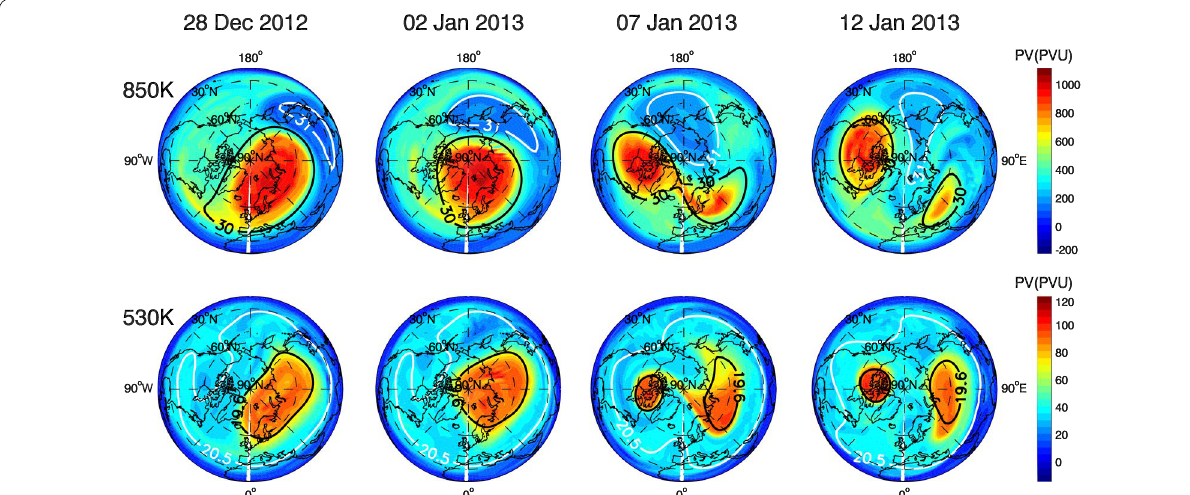
10 − 6 Kkg − 1 m 2 s − 1 ) at 850 K (top) and 530 K (bottom) potential temperature surface Fig. 6 Maps of potential vorticity (in PVU where 1 PVU = on 28 December 2012, 2 January 2013, 7 January 2013 and 12 January 2013 (from left to right) in the NH. The overlaid contour represents the geopotential heights at 10 hPa (top) and 50 hPa (bottom), where the black and white solid thick lines denote different values (km). The domain is from the equator to the pole with dashed circles at 30 ◦ N and 60 ◦ N ; 0 ◦ longitude is at the bottom and 90 ◦ E is to the